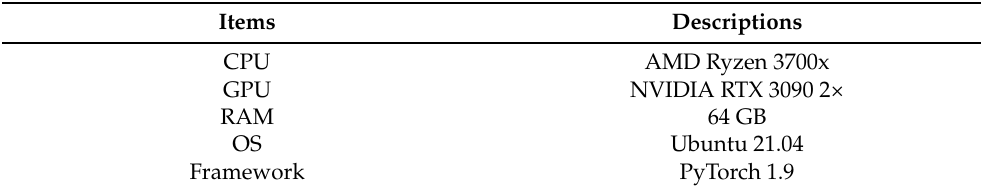
Table 1. Hardware and software environment. Items